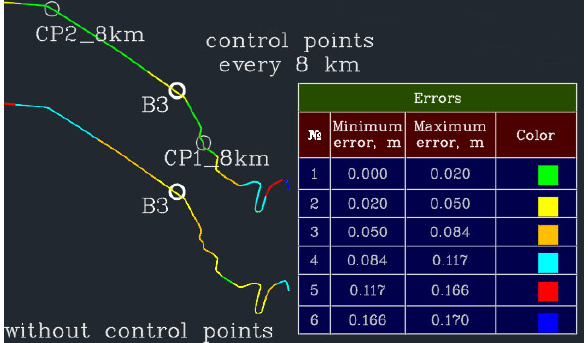
Figure 9. The comparison of the trajectoriy adjusted with control points every 8km and the trajectory without adjustment using control points